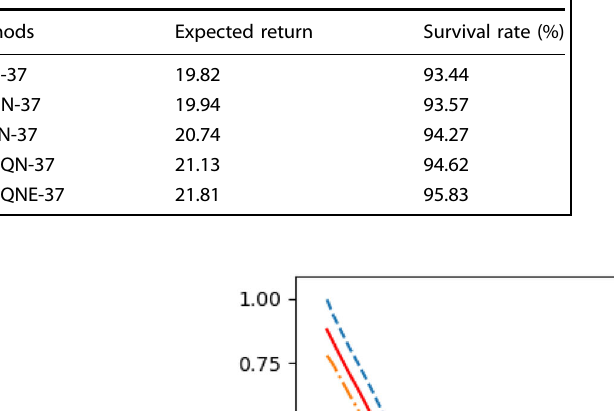
Table 3. Off-policy evaluation performance of baselines in the eRI set.